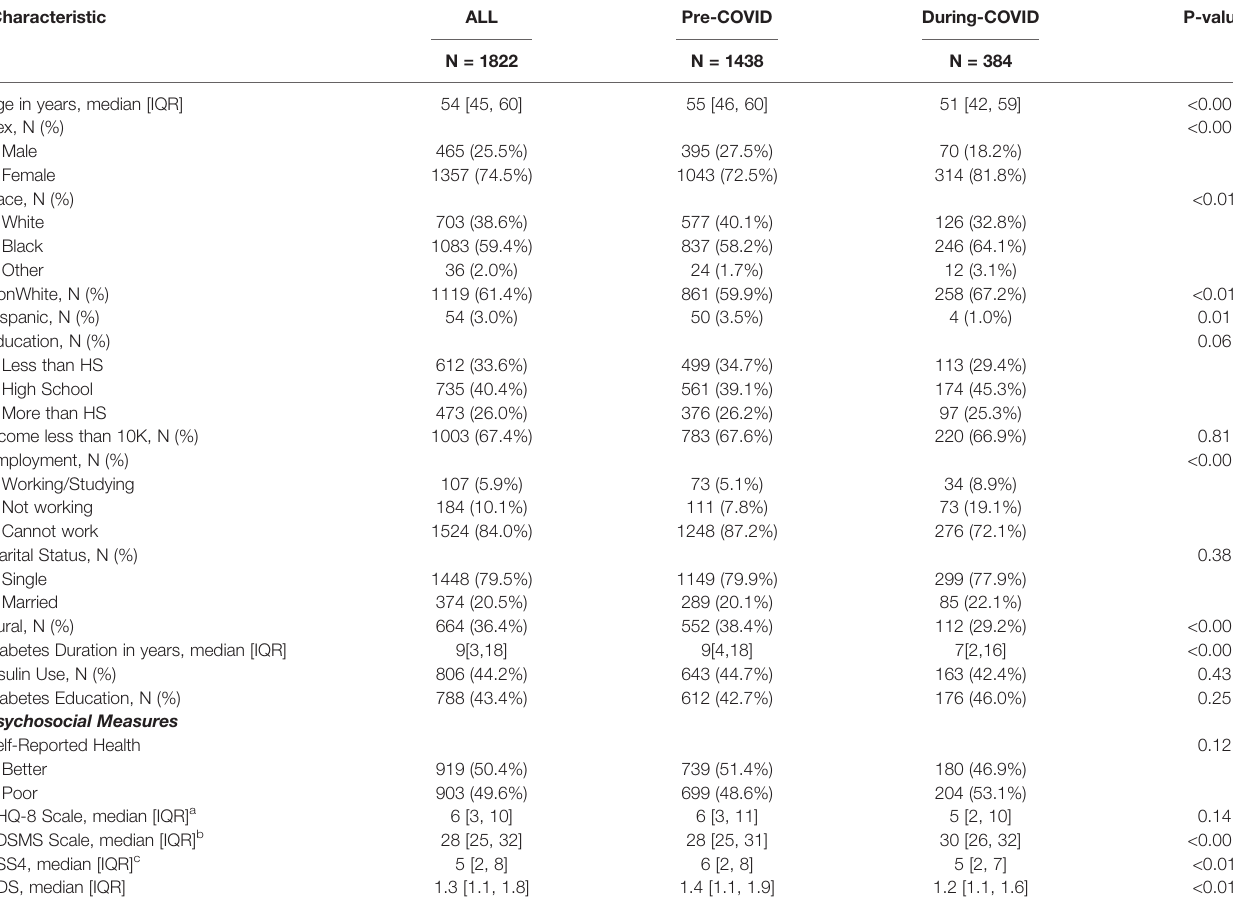
TABLE 1 | Characteristics of survey participants with type 2 diabetes covered byAlabama Medicaid prior to the COVID-19 pandemic andduringthe COVID-19 pandemic. Characteristic ALL N = 1822 Age in years, median [IQR]